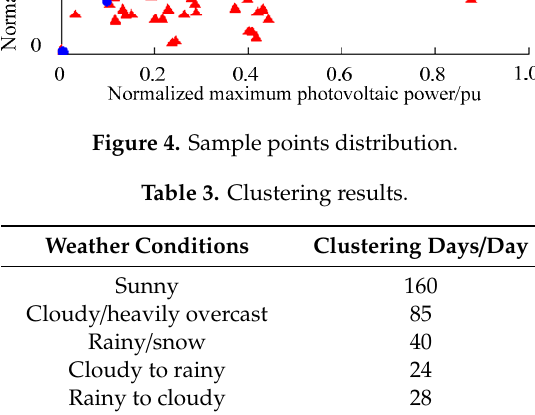
Figure 4. Sample points distribution.